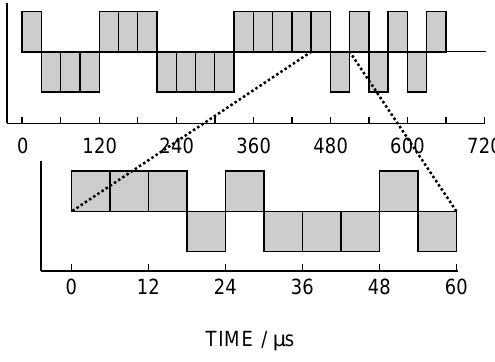
Fig. 3. The modulation pattern applied in the experiment. The 22- bit basic modulation is shown in the top and the Barker-coded struc- ture of a positive bit and the subsequent negative bit is shown at the